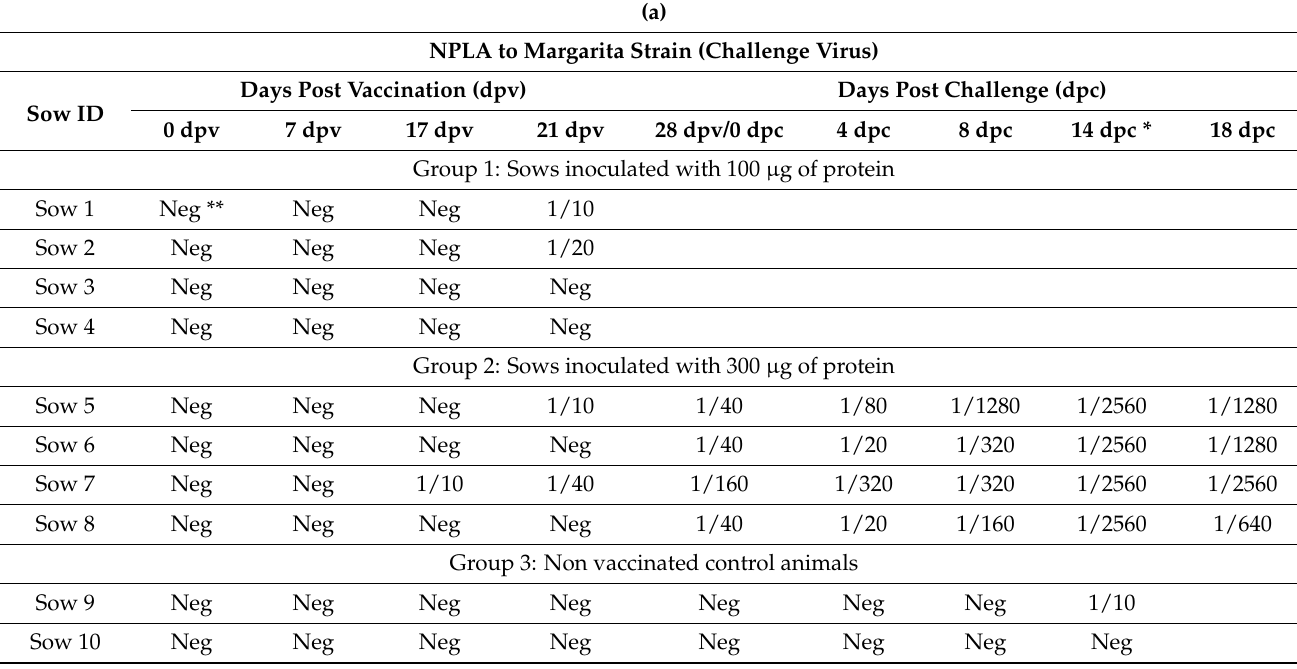
Table 1. CSFV neutralizing peroxidase linked antibody (NPLA) titer: ( a ) NPLA titer to CSFV strain Margarita, ( b ) NPLA titer to CSFV strain Alfort/187.